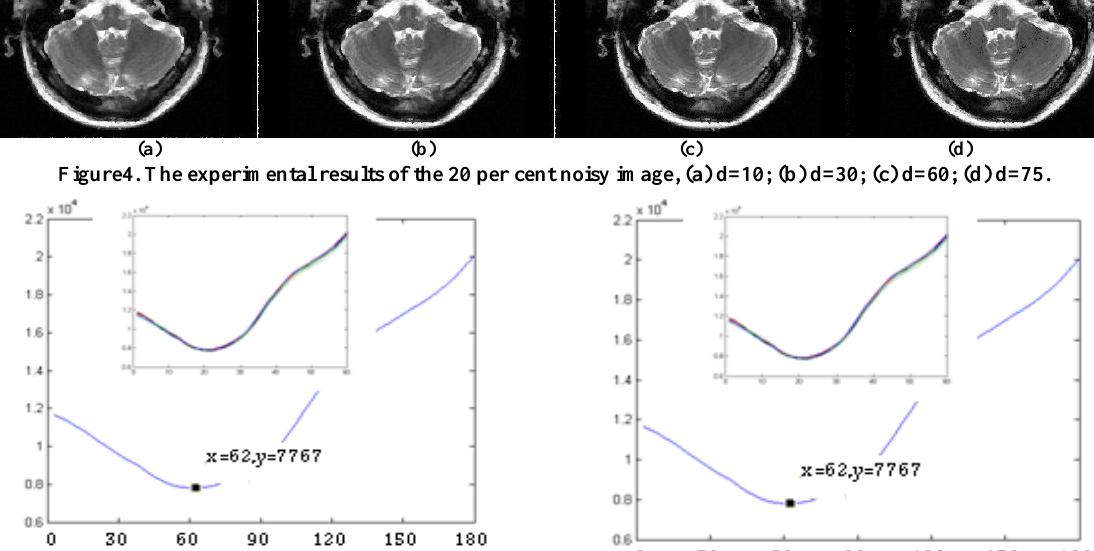
Figure4. The experimental results of the 20 per cent noisy image, (a) d=10; (b) d=30; (c) d=60; (d)